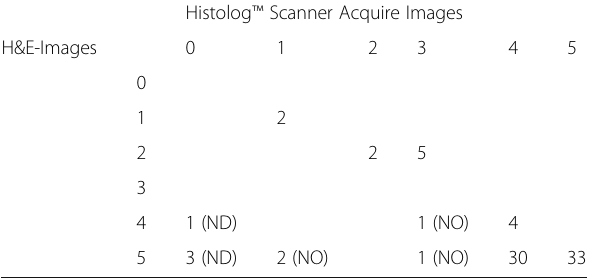
Table 1 Results: B-classification of Confocal scanner images compared to B-classification of H&E